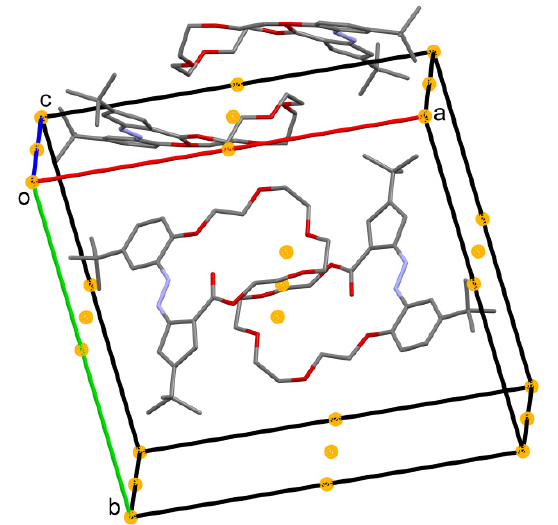
Figure 9. Crystal packing of t -Bu-19- p -OH, flat molecules form layers parallel to (-202) family of planes. Hydrogen atoms are omitted.